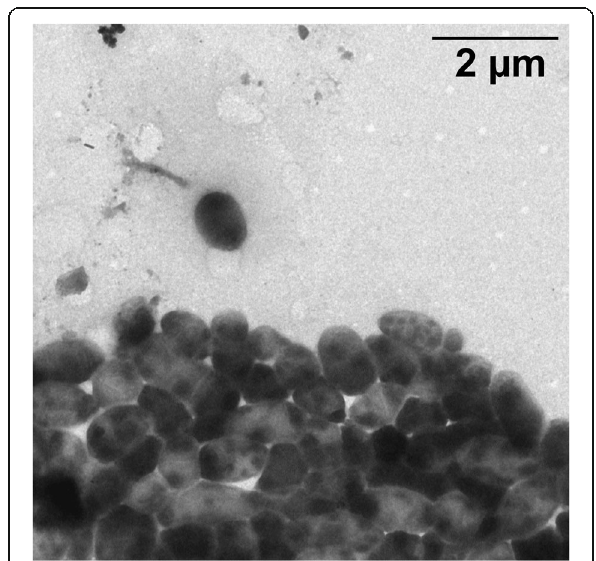
Fig. 2 Transmission electron micrograph of Planktotalea frisia SH6-1